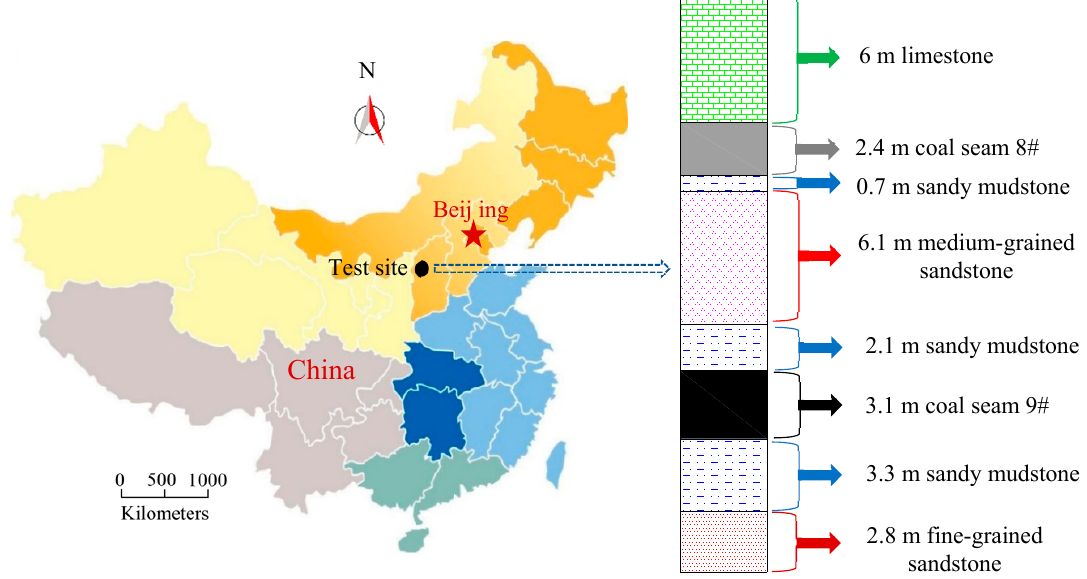
Figure 10. Location of the mine and lithology of the rock layers.